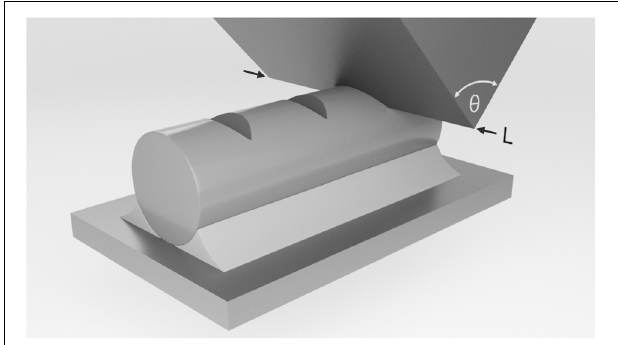
FIGURE 1 | Schematic representation of a nanoindentation experiment on a silica glass fiber using a wedge-shaped tip with the opening angle θ and the effective length L .